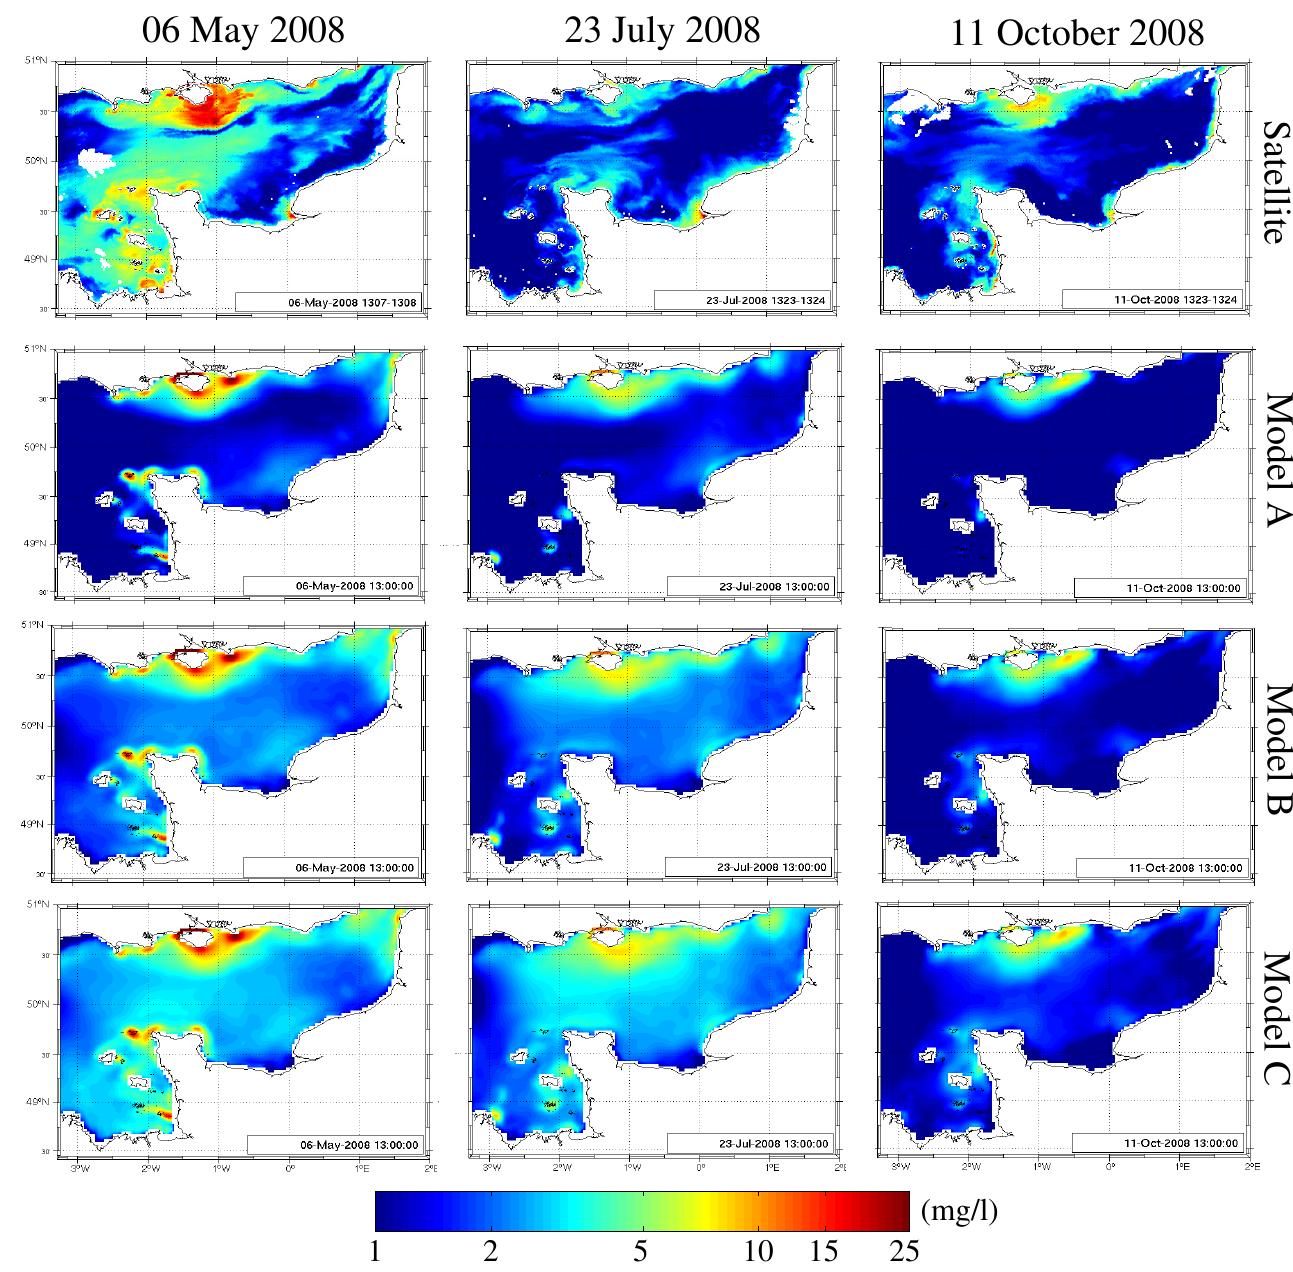
Figure 7. Near-surface SSC observed and computed in Configurations A, B and C for moderate waves conditions and spring (6 May 2008, MODIS), mean (23 July 2008, MODIS) and neap (11 October 2008, MODIS)